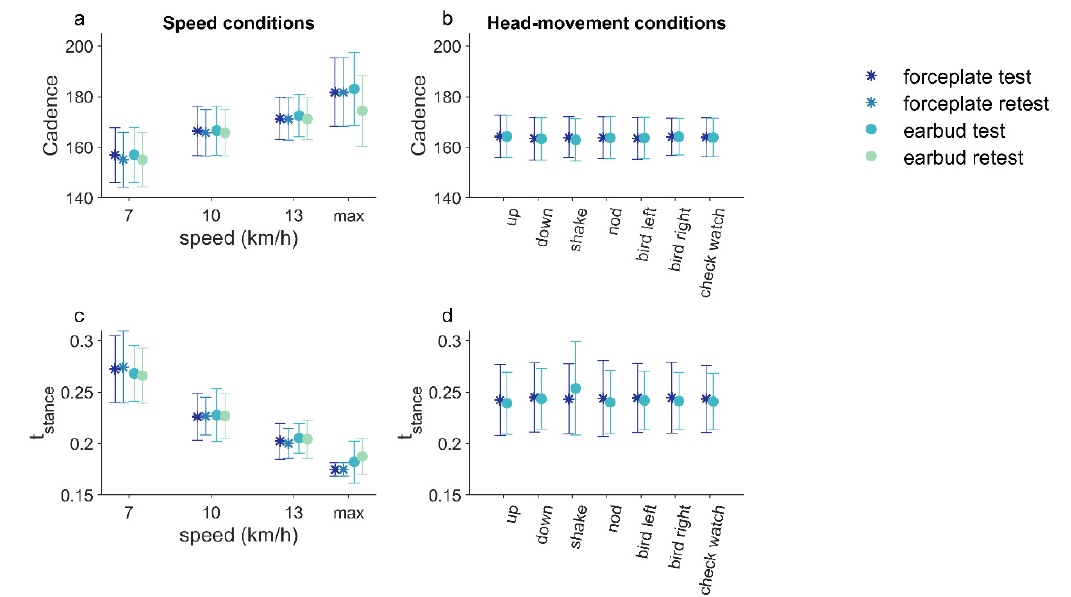
Figure 4. Mean and standard deviation of cadence ( a , b ) and stance time ( c , d ) for the two methods for test and retest for the different speed conditions ( a , c ) and for the head-movement conditions ( b , d ).